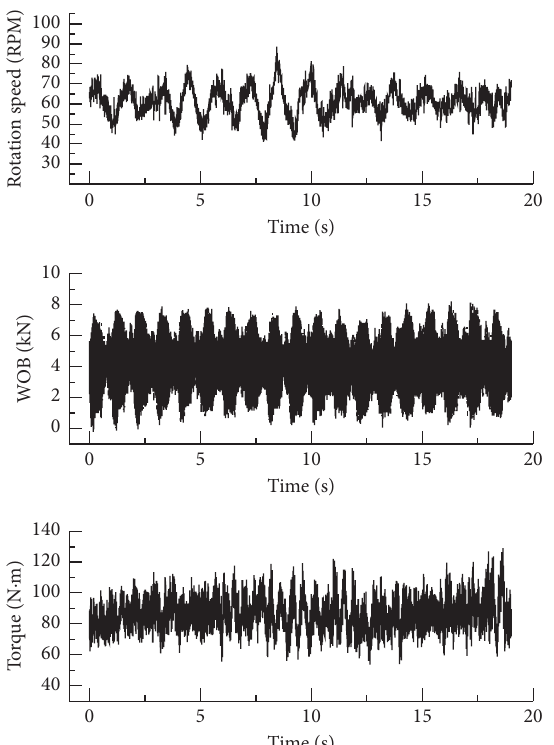
Figure 5: Test result of suppressing stick slip by axial impact.